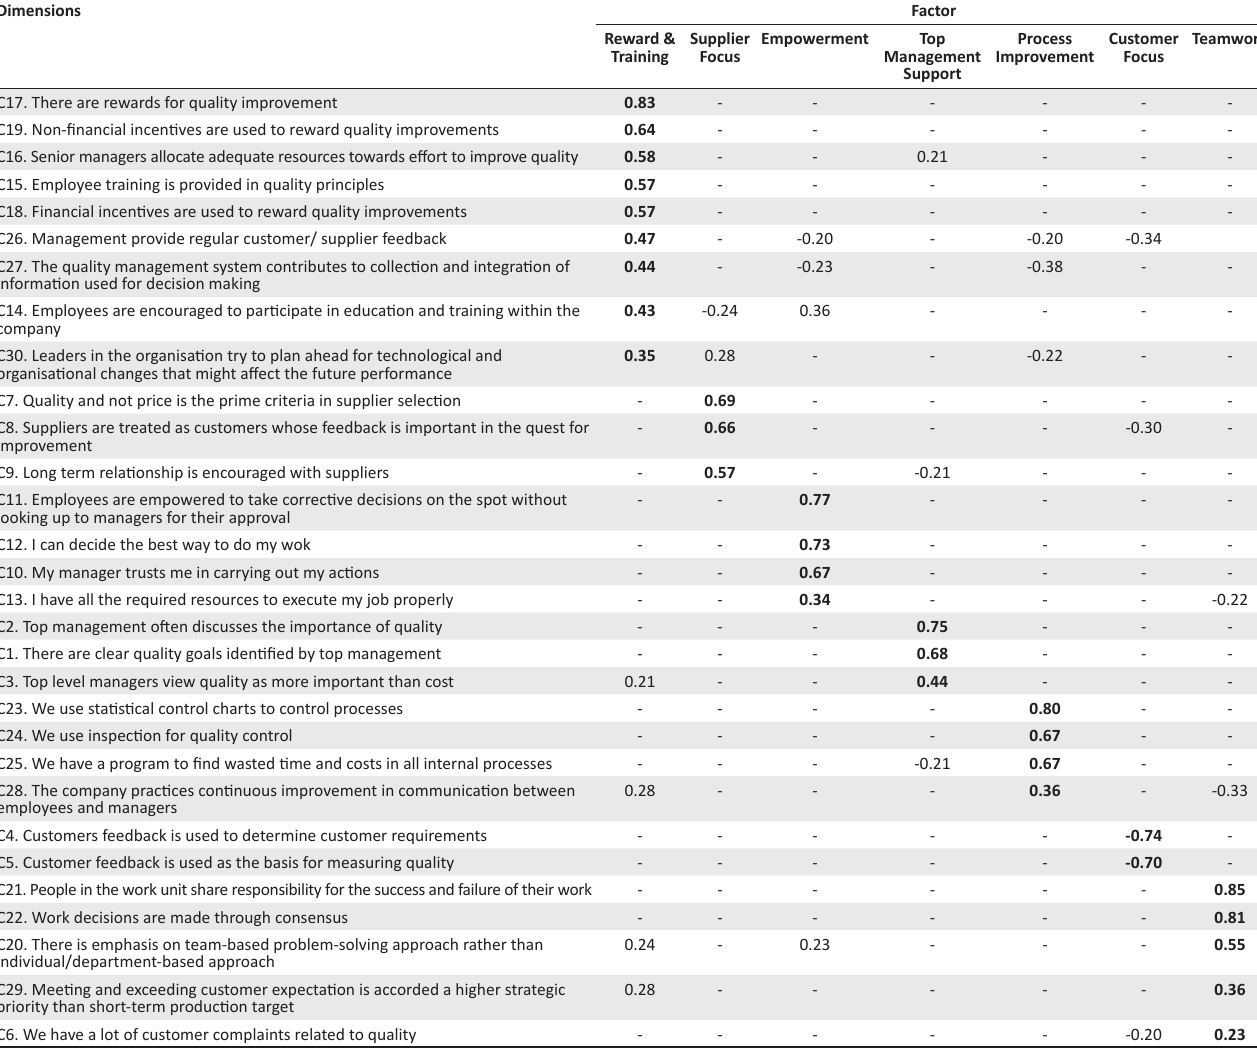
TABLE 1-A1: Factor loadings of the dimensions of total quality management.